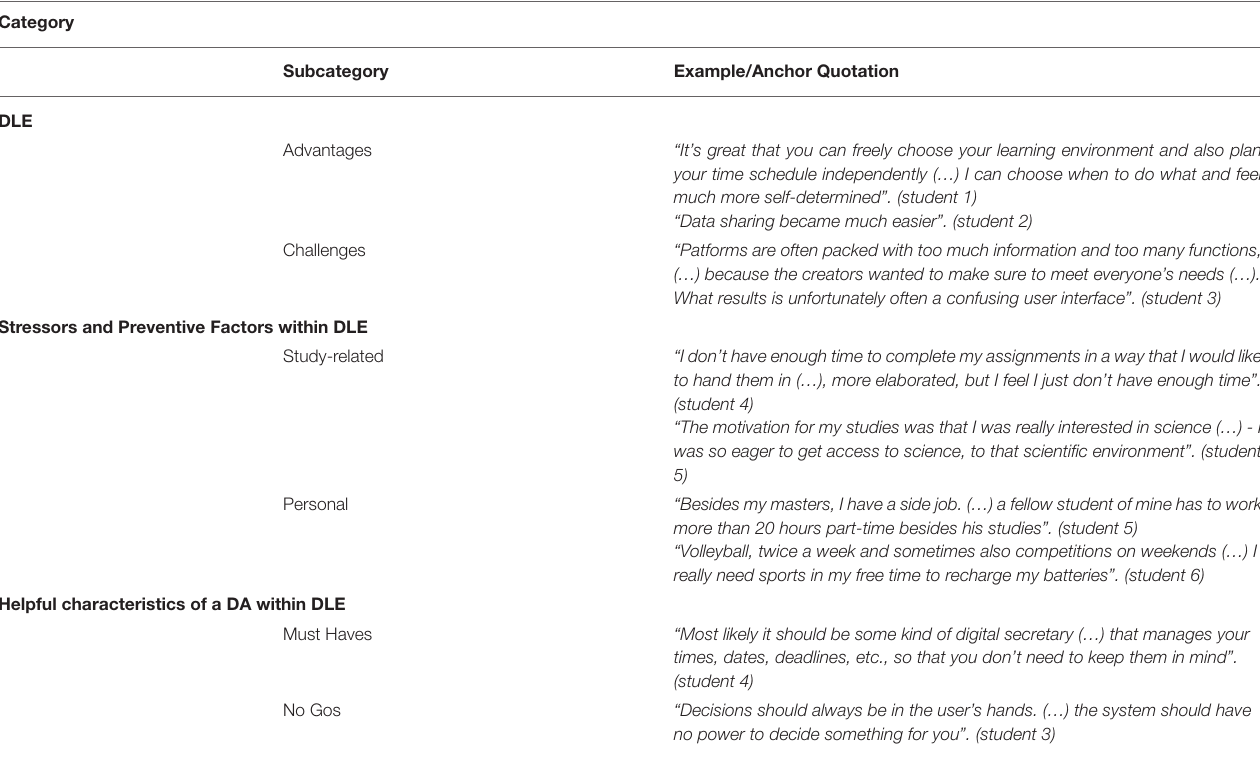
TABLE 2 | Examples and anchor quotations for each category and its